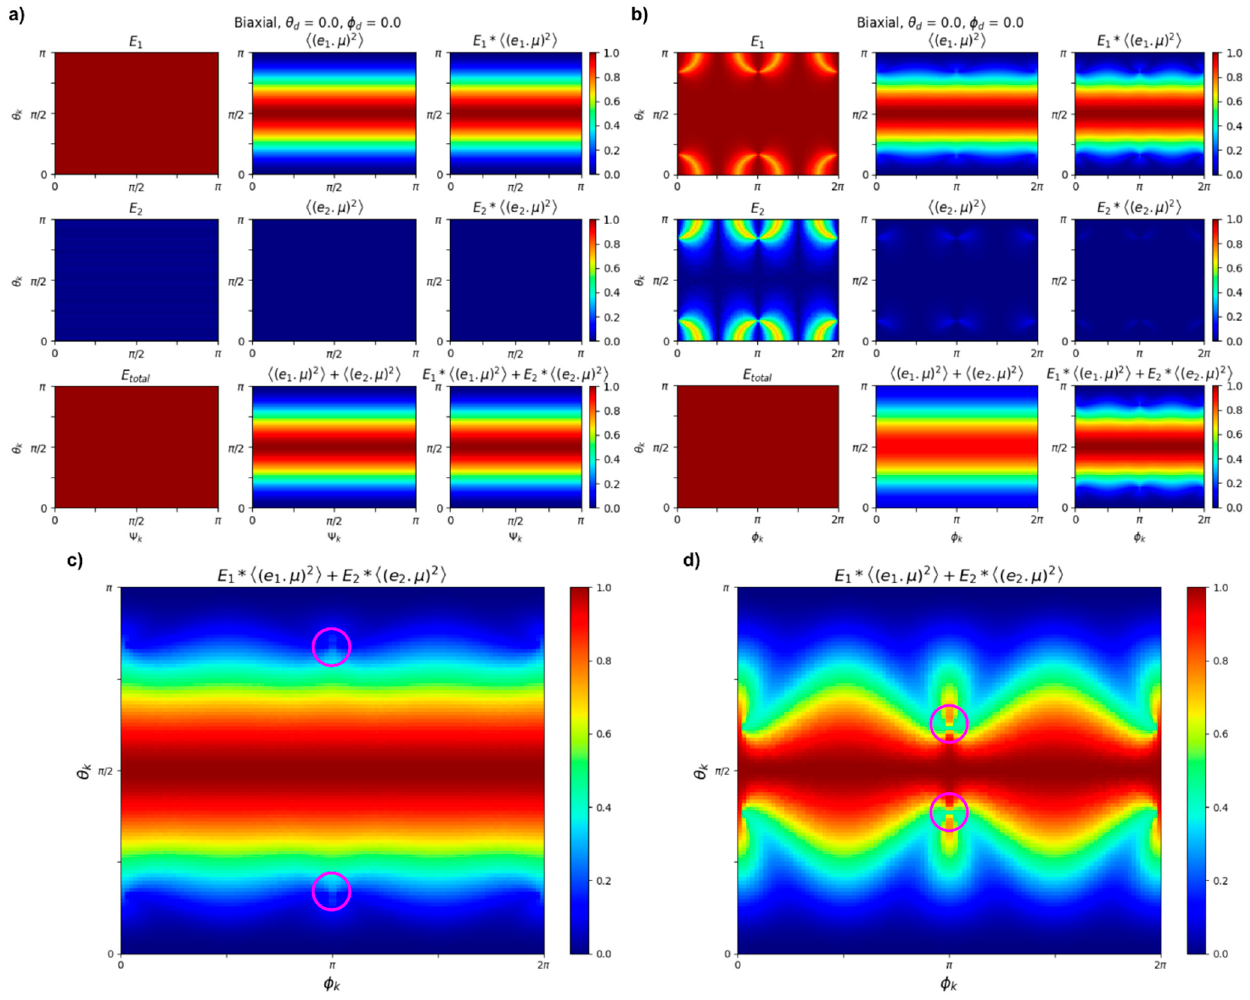
Figure 5. Modelled distributions of the electric field, (cid:104) ( ˆ µ n · ˆ e n ) 2 (cid:105) , and their products for a theoretical biaxial protein crystal that is dipole-oriented along a two-fold symmetry axis. These are shown mapped over θ k , ψ k ( φ k = 0 ) ( a ) and θ k , φ k ( ψ k = 0 ) ( b ). The refractive index distribution was chosen to be the same as the topaz modelled in Figure 3. Also shown are zoomed plots of the total product ( E 1 ∗ (cid:104) ( ˆ µ · ˆ e 1 ) 2 (cid:105) + E 2 ∗ (cid:104) ( ˆ µ · ˆ e 2 ) 2 (cid:105) ) for a topaz ( c ) and the same model repeated for a muscovite-like refractive index distribution ( d ). The location of the optic axis (pink rings) can be seen to impact the distributions.